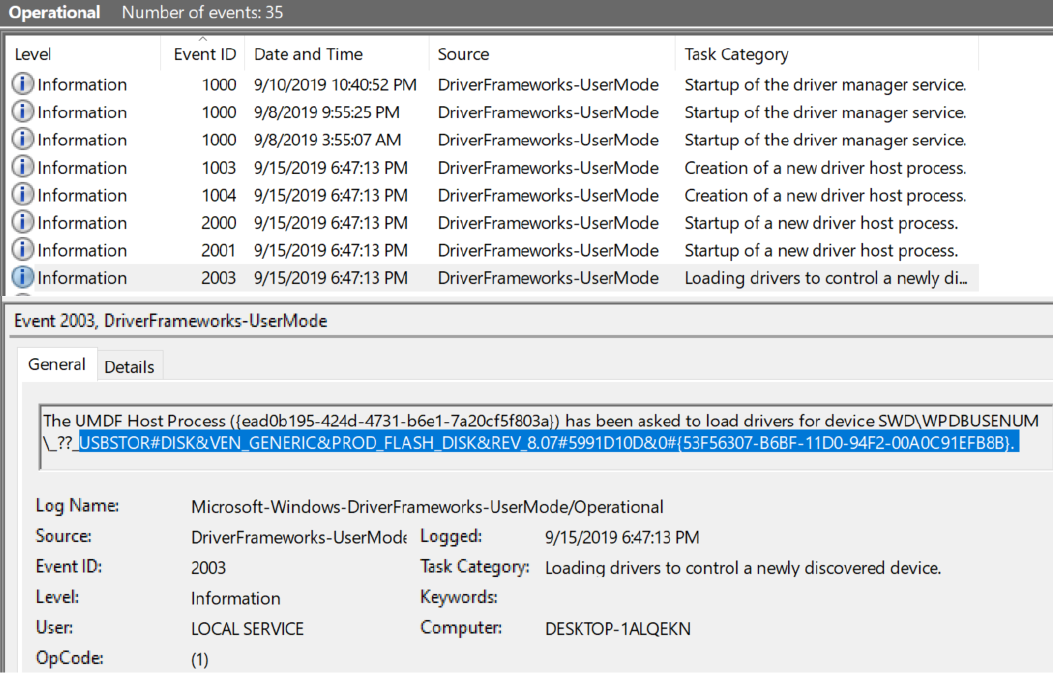
Figure 3. Event ID 2003 in Windows Event Viewer.